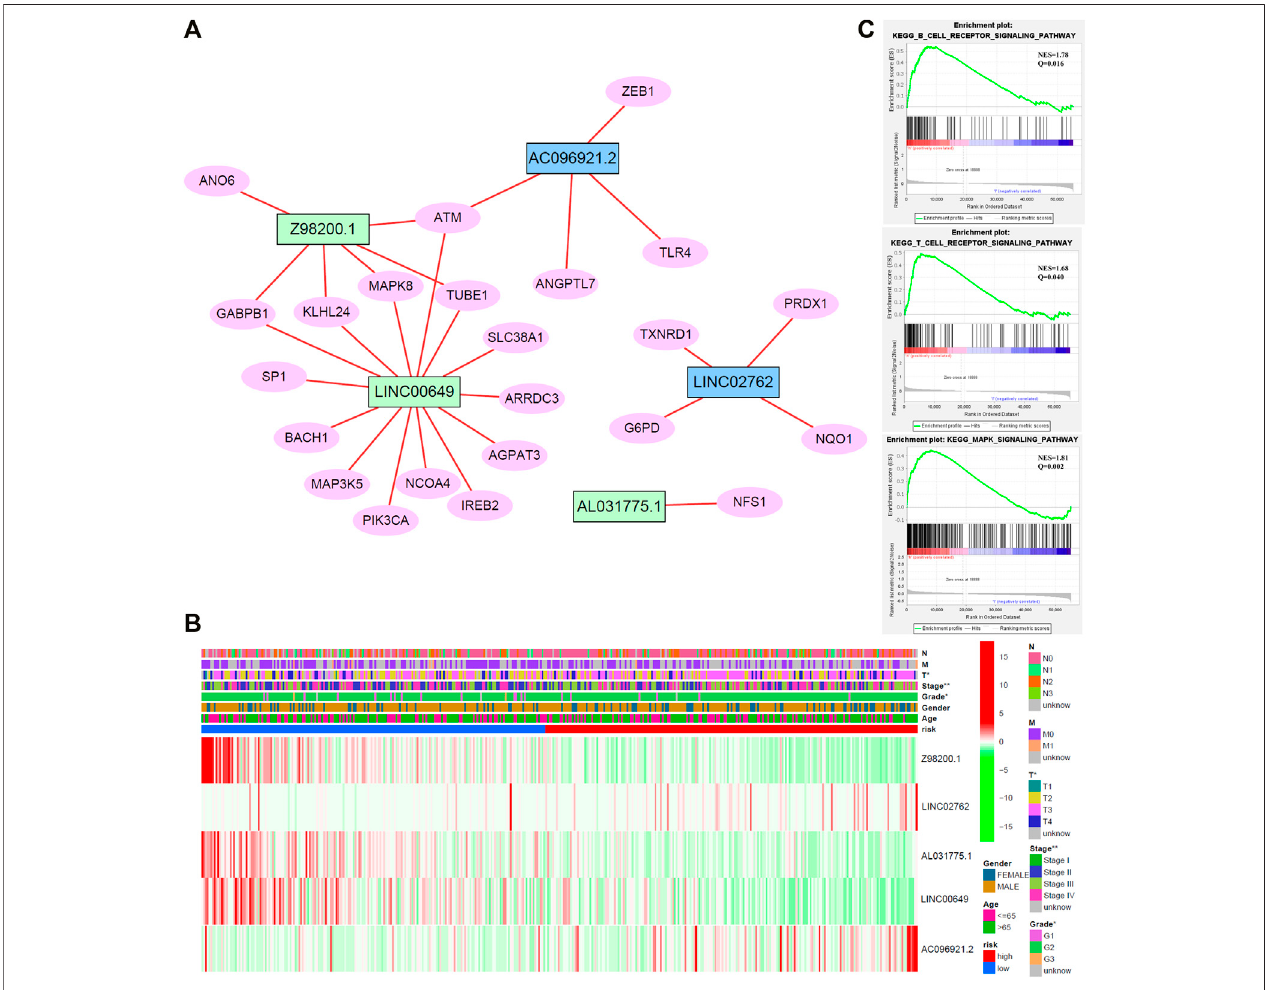
FIGURE 6 | (A) Network diagram of fi ve target lncRNA-related genes. (B) Cluster analysis. (C) Gene set enrichment analysis (GSEA) of target lncRNAs.